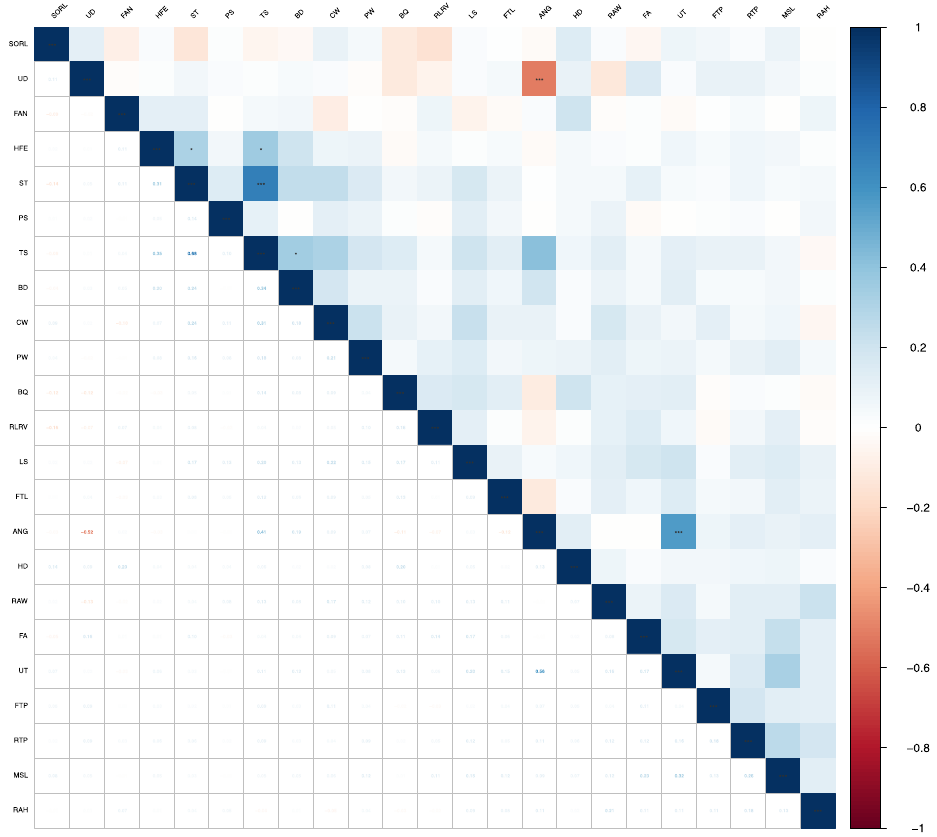
Figure 2. Phenotypic correlations between conformation traits in Chinese Holsteins. The upper triangle is the result of the significance test, and the lower triangle is the Pearson correlation coefficient. Blue represents a positive correlation and red represents a negative correlation. * : significant level less than 0.05, ** : significant level less than 0.01, *** : significant level less than 0.001.